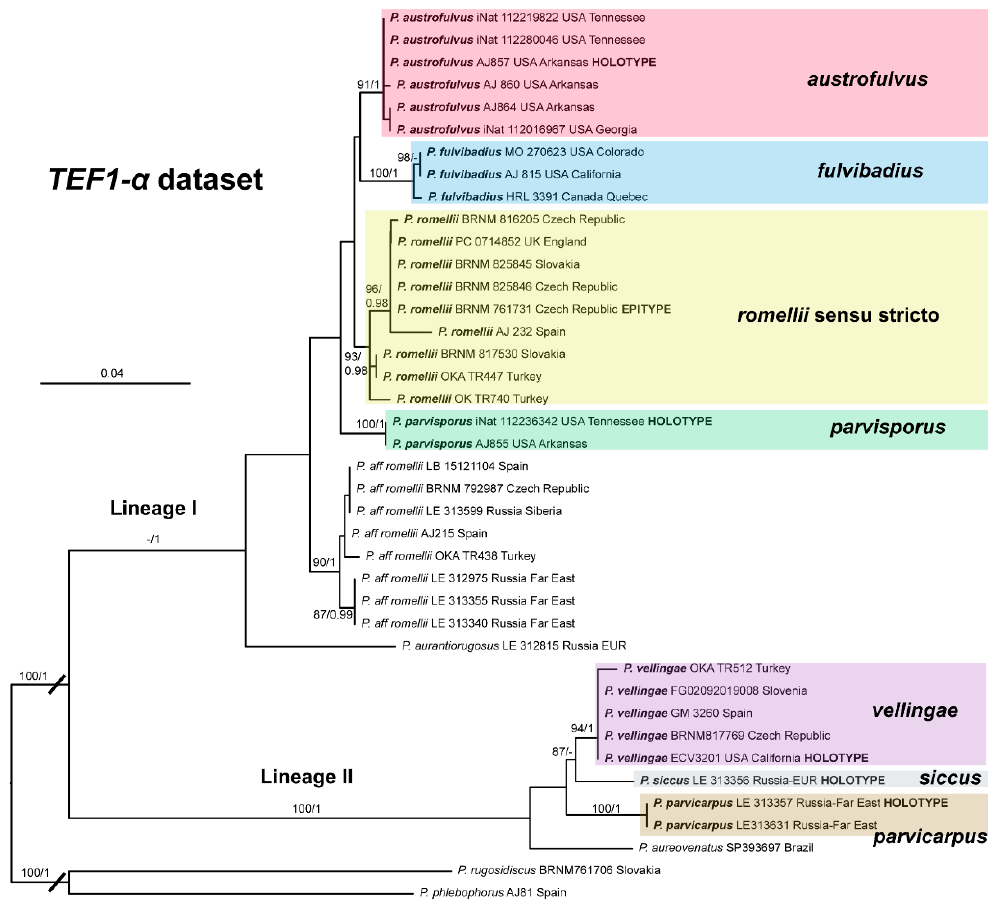
Figure 3. Best tree from the ML analysis of the TEF1- α dataset. BS values ( ≥ 70%) and PP values ( ≥ 0.90) are shown on or below the branches. Root length has been reduced to accommodate graphical representation. Scale bar indicates the mean number of nucleotide substitutions per site.